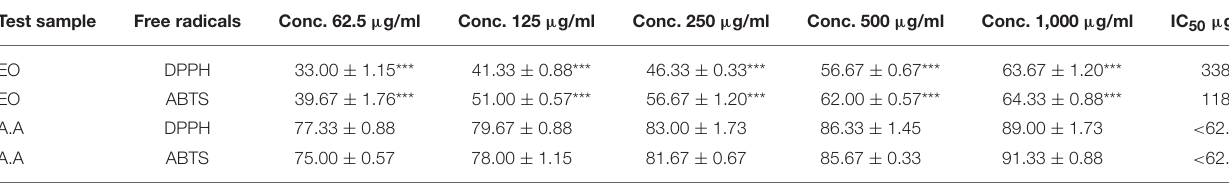
TABLE 5 | Antioxidant activity of essential oil of Isodon rugosus at various concentrations. Test sample